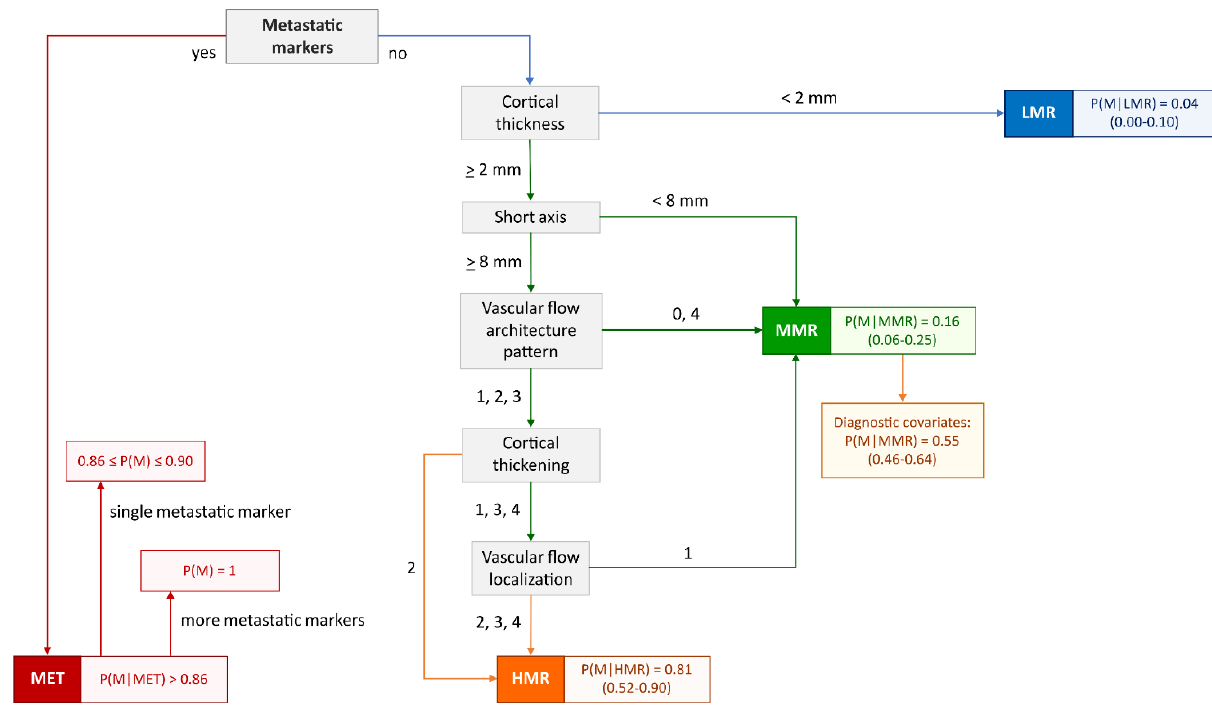
Figure 4. Decision tree flow chart: risk signatures.